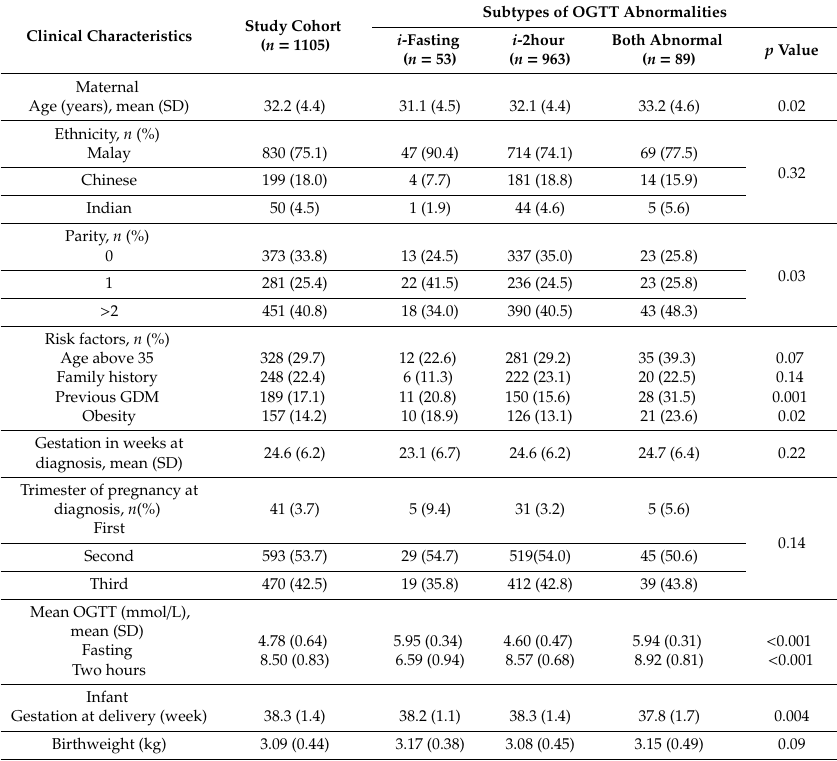
Table 1. Clinical Characteristics for study population and subtypes of oral glucose tolerance test (OGTT) abnormalities.